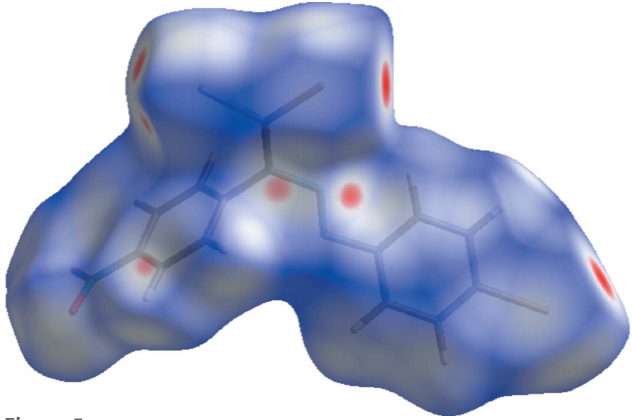
The C10—H10 (cid:2) (cid:2) (cid:2) Br1 interactions, which are important for molecular packing of the title compound, are responsible for the red patch that appears around Br1.